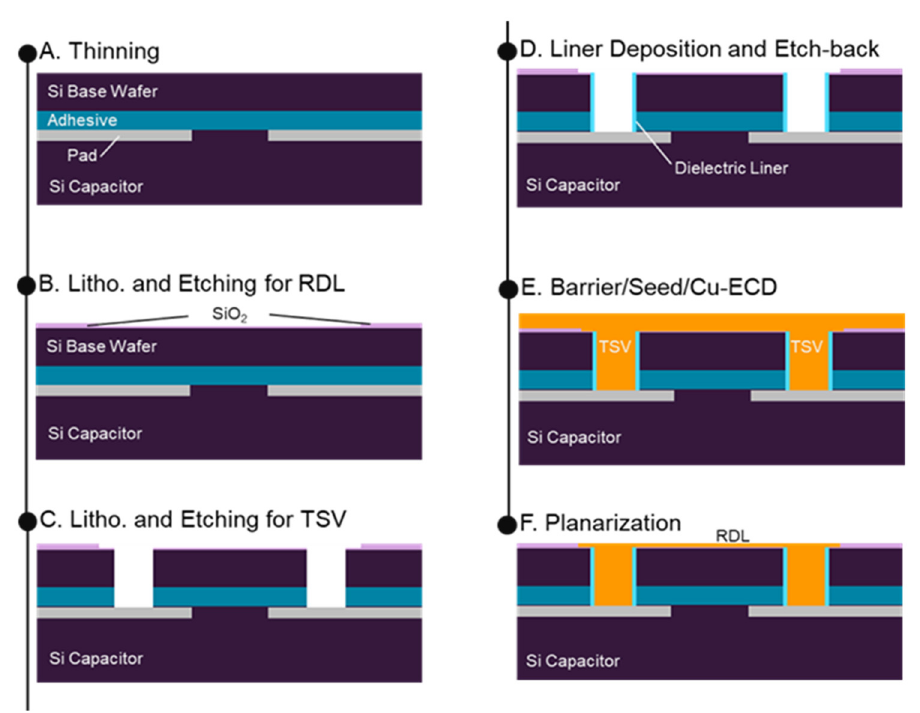
Figure 21. Process sequence of TSV/RDL formation after chip placement and wafer bonding.